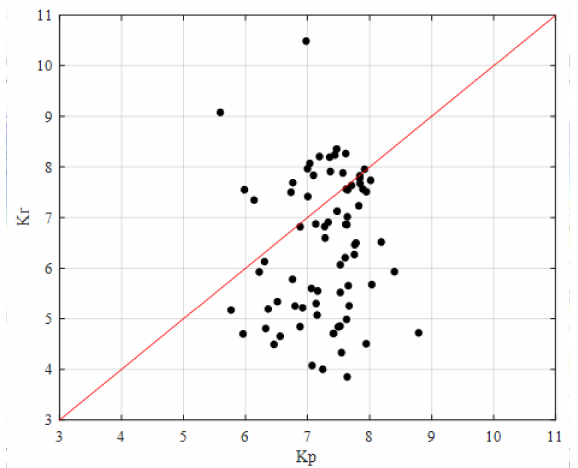
Figure 6. Slopes of δ 2 H- δ 18 O relation in precipitation and river water. Kp and Kr stands for slope of δ 2 H- δ 18 O relation in precipitation and river water, respectively. Each point represents Kp and Kr of a watershed. Red line is the 1:1